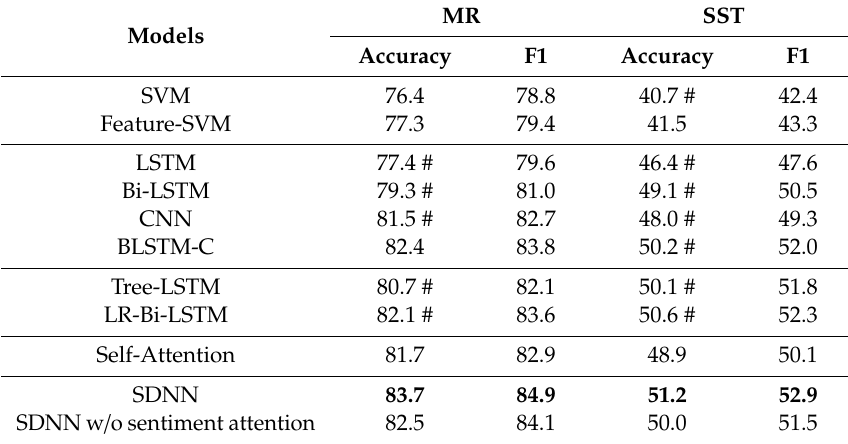
Table 2. Evaluation results (%) for the MR and SST datasets. The best result for each dataset is in bold. Results marked with # were retrieved from the references (i.e., [20,22,26,27]), while those unmarked with # were obtained either by our own implementation or with the same codes shared by the original